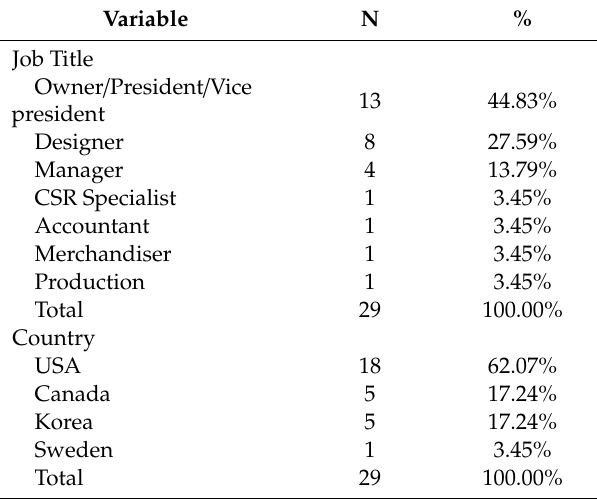
Table 1. Participant